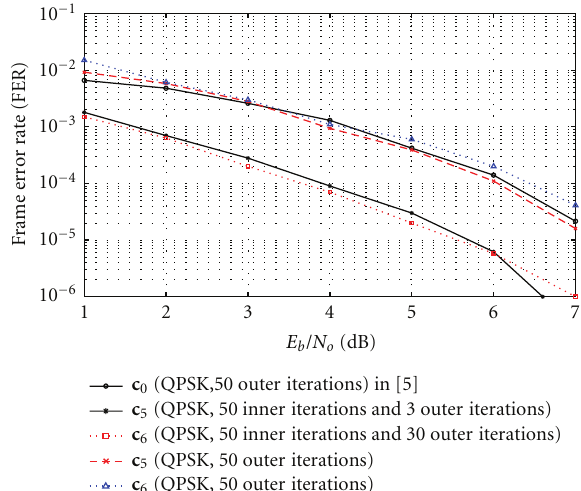
Figure 1: FER performances of the proposed LDMCs c 5 and c 6 with QPSK